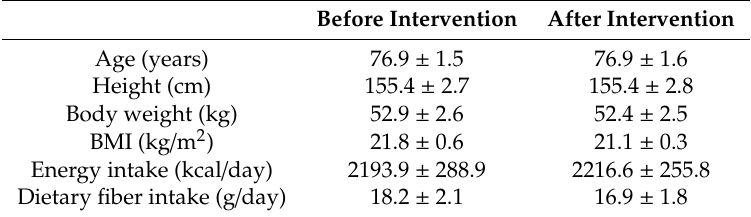
Table 2. Physical characteristic of all the participants at before and after the intervention. Before Intervention After Intervention